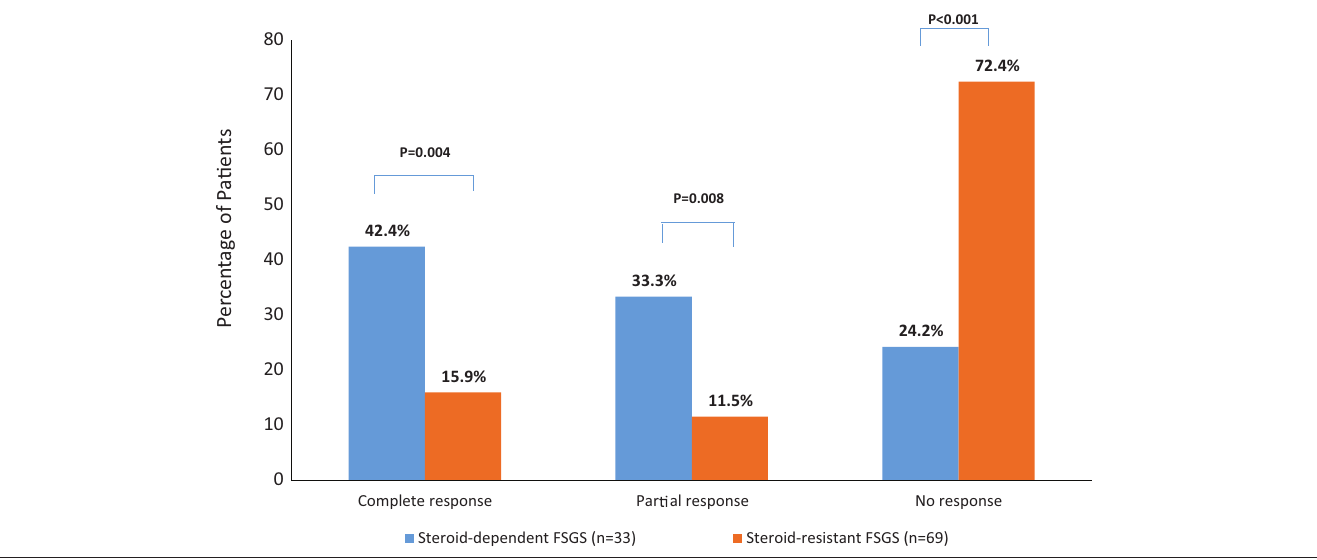
Figure 2. Comparison of responses to cyclosporine according to steroid-dependent and steroid-resistant nature of focal segmental glomerulosclerosis (n =